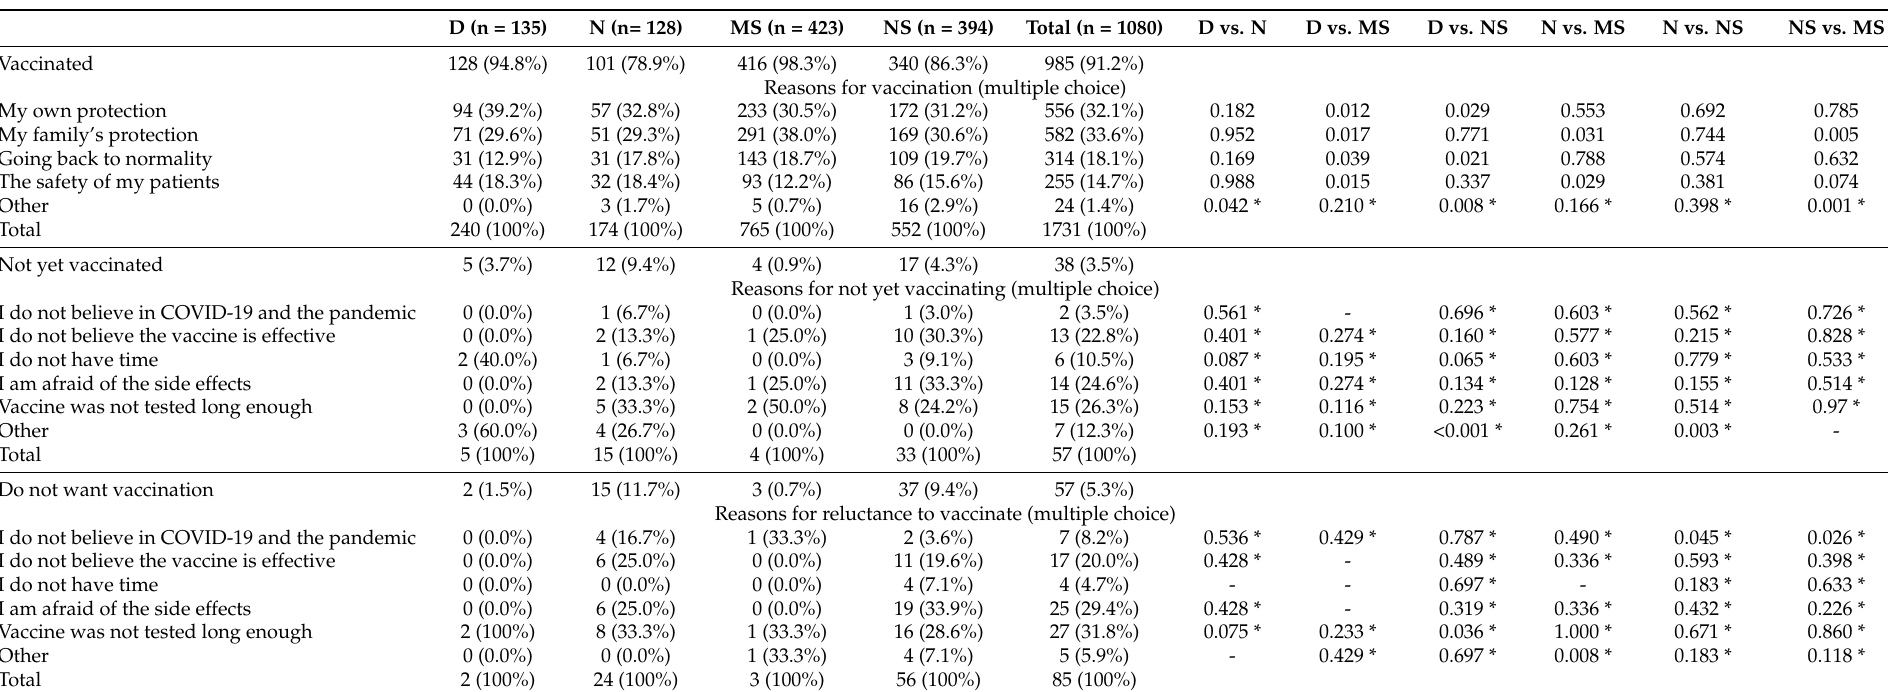
Table 2. Differences (%) between four groups of healthcare workers (doctors, nurses and midwives, medical students, and nursing students) and reasons for vaccination or non-vaccination against